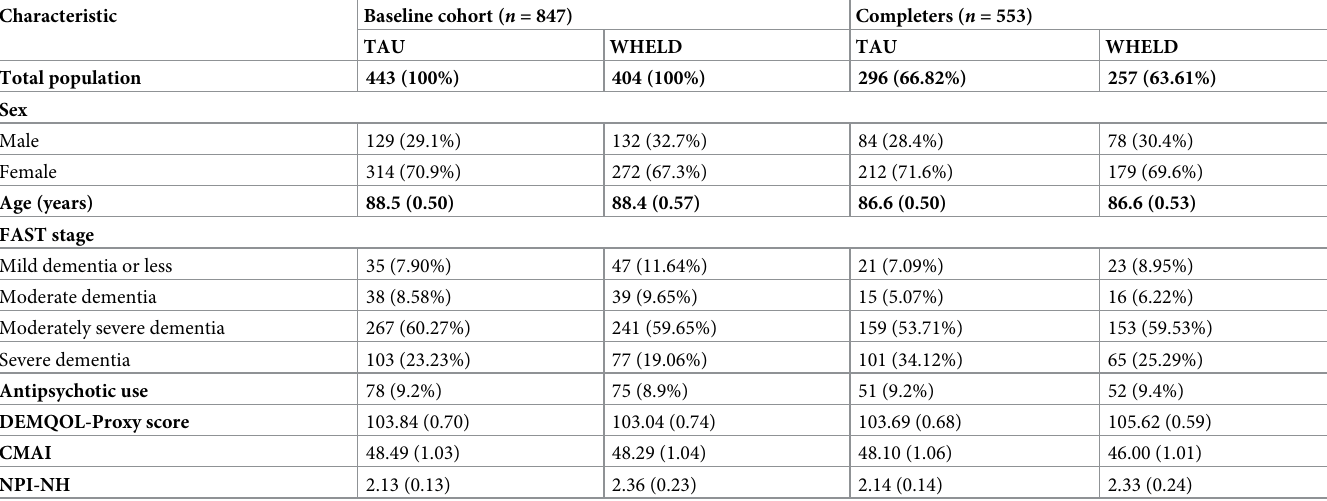
Table 1. Descriptive statistics for baseline cohort and completers.